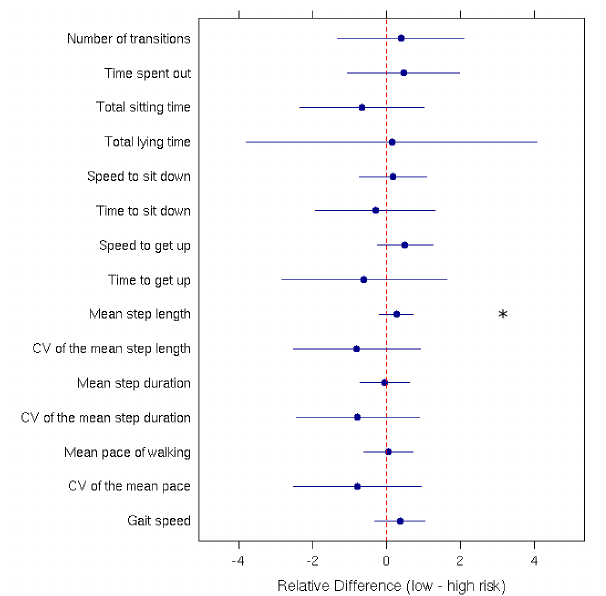
Figure 3. Relative difference (with the 95% confidence interval) between low and high fall-risk pa- tients for each measured parameter. The ‘*’ indicates a significant difference between the two